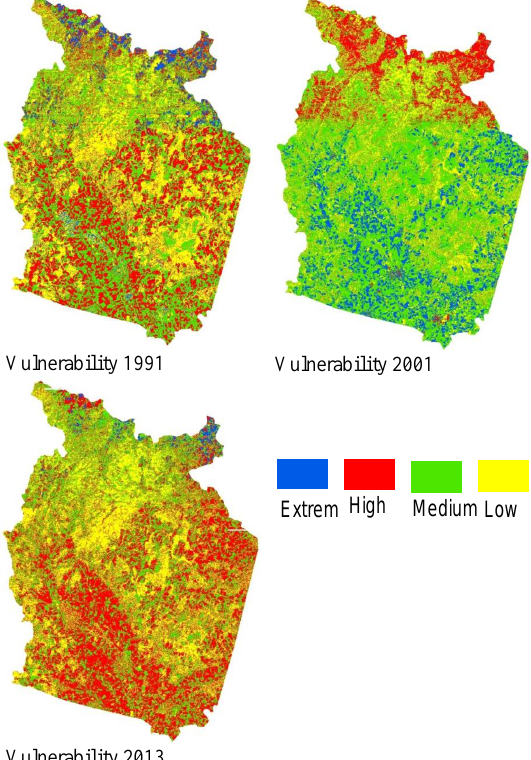
Figure 3. Vulnerability maps of the study